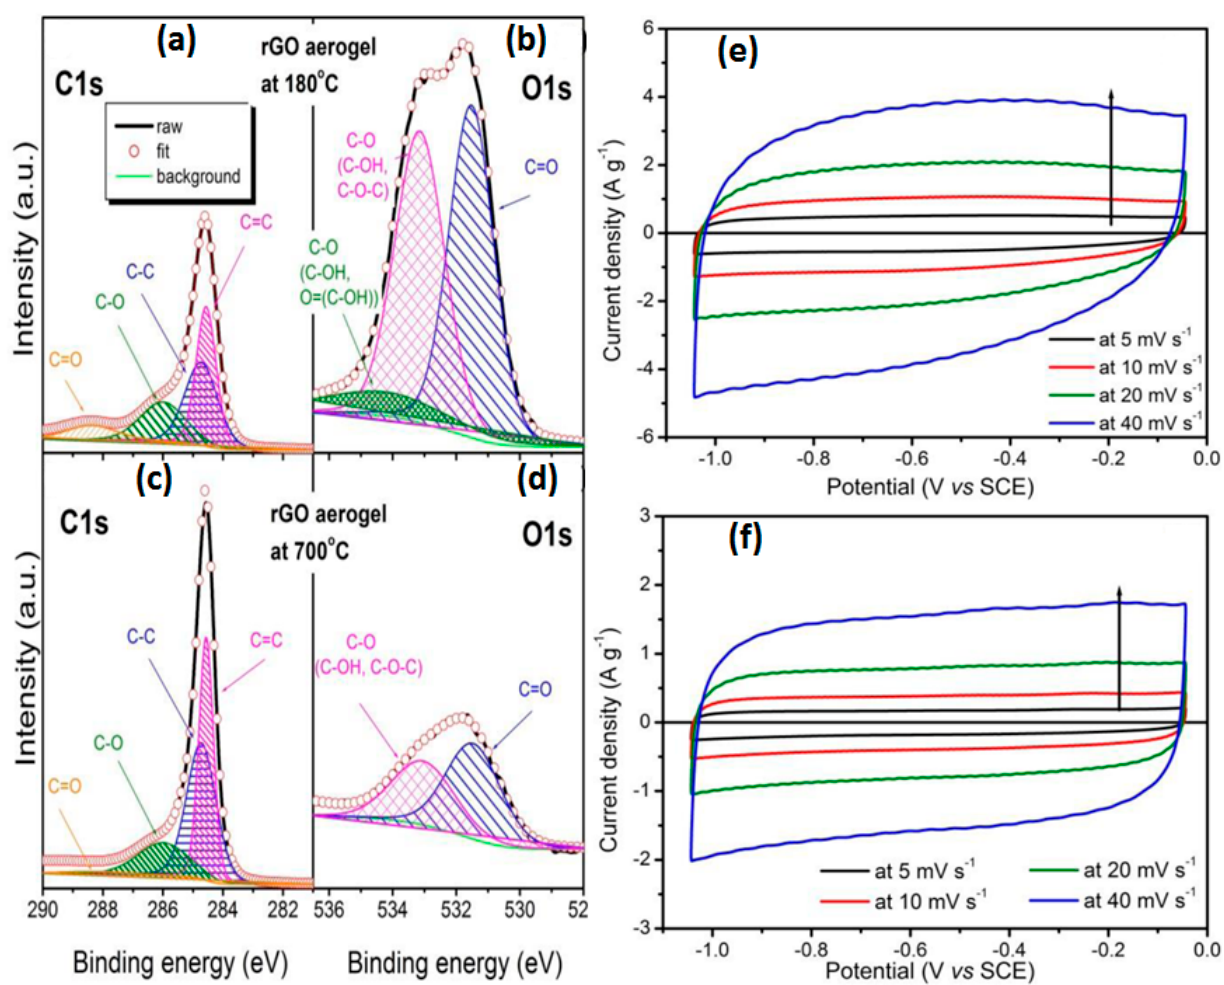
Figure 5. Carbon (C1s) ( a , c ) and oxygen (O1s) ( b , d ) spectra obtained by X-ray photoelectron spectroscopy (XPS) on graphene oxide (GO) aerogel reduced at 180 °C in vacuum ( a , b ) and at 700 °C in Ar ( c , d ). Cyclic voltammetry profiles at different scan rates for the rGO-CNT-based composite electrodes on carbon cloth with 180 °C ( e ) and at 700 °C ( f ) rGO (Reproduced with permission of [20]. Copyright Elsevier, 2020).